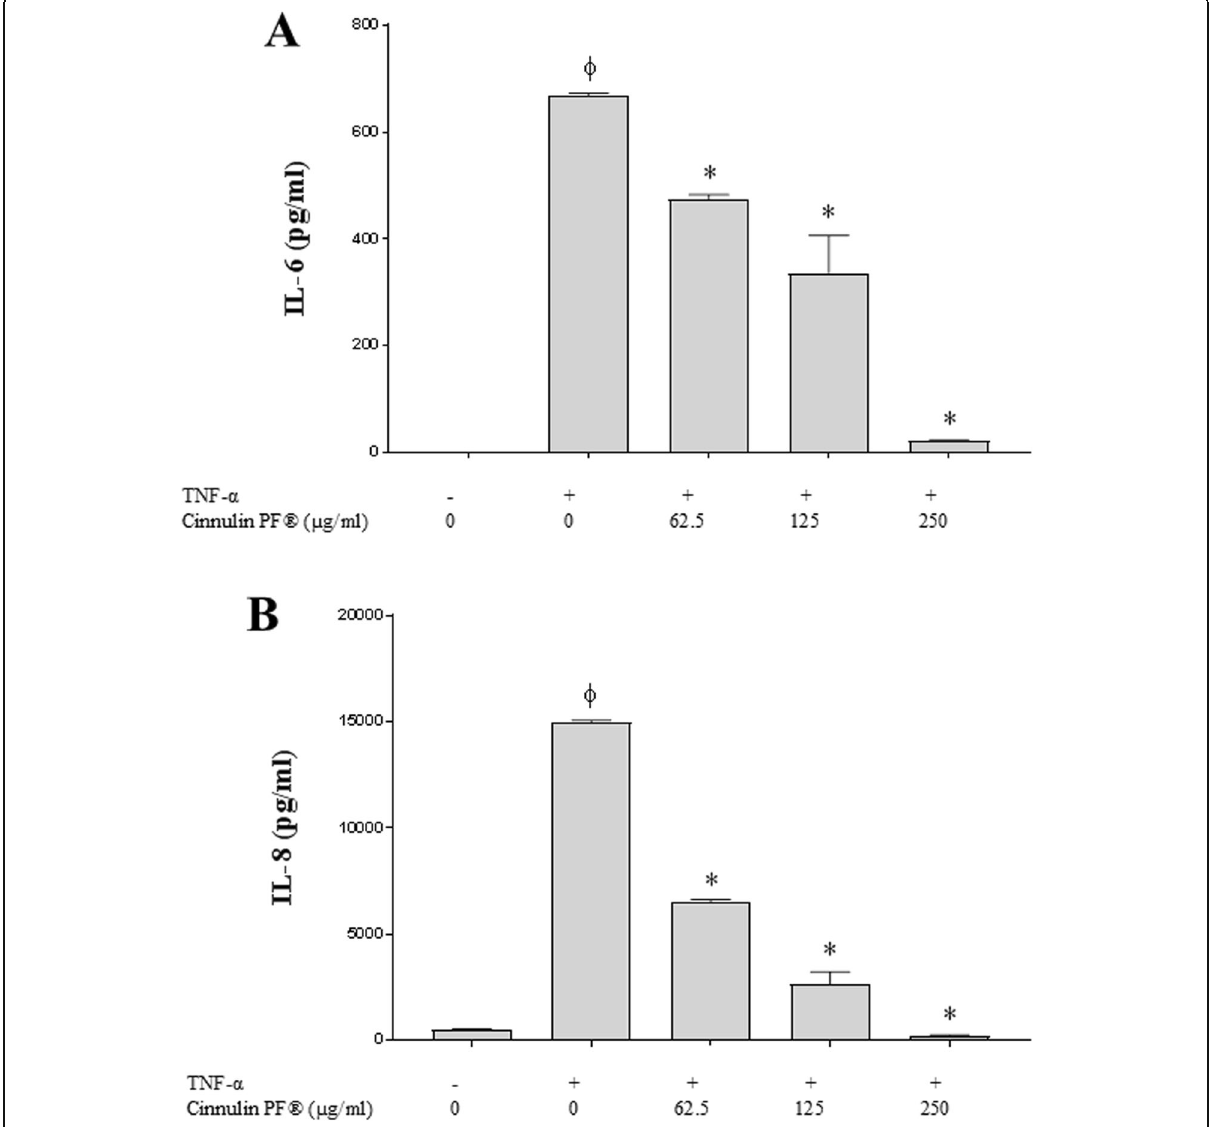
Fig. 8 Effect of Cinnulin PF® on TNF- α -induced IL-6 (panel a ) and IL-8 (panel b ) secretion by oral epithelial cells (GMSM-K cell line). Results are expressed as the means ± SD of triplicate assays in two independent experiments. *: significantly different from the control ( p <